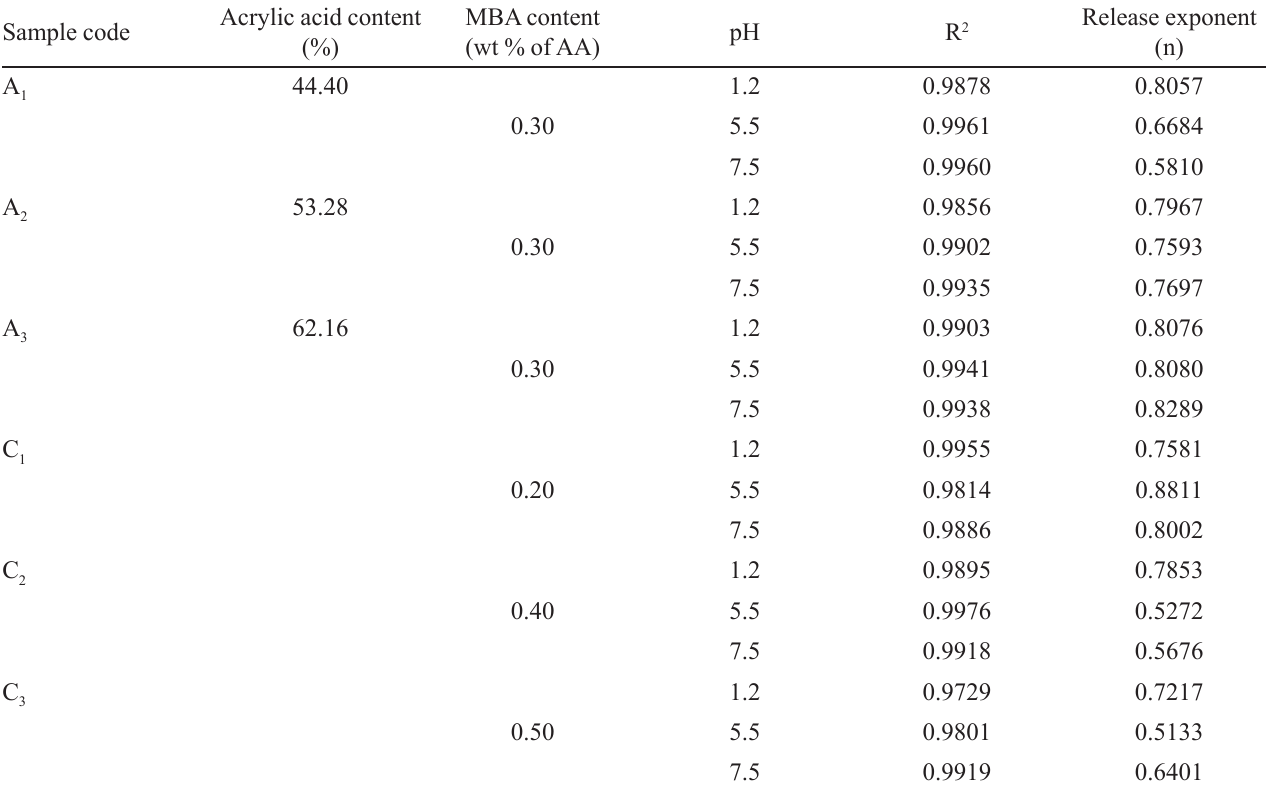
TABLE V - Effect of acrylic acid and MBA on the tramadol release mechanism of PVP/AA hydrogel at different pH Sample